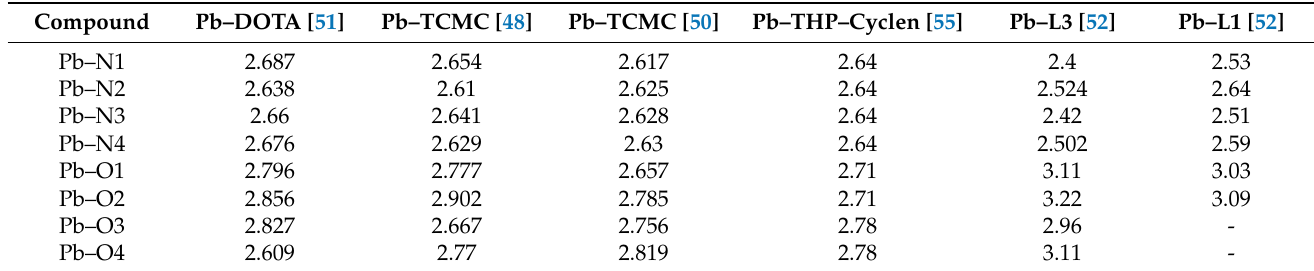
Table 1. Bond lengths in crystal structures of Pb2+ complexes with